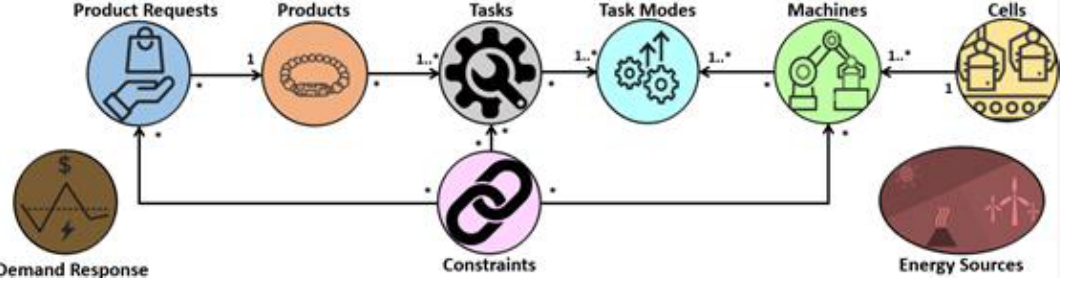
Figure 1. Domain model of the proposed methodology.